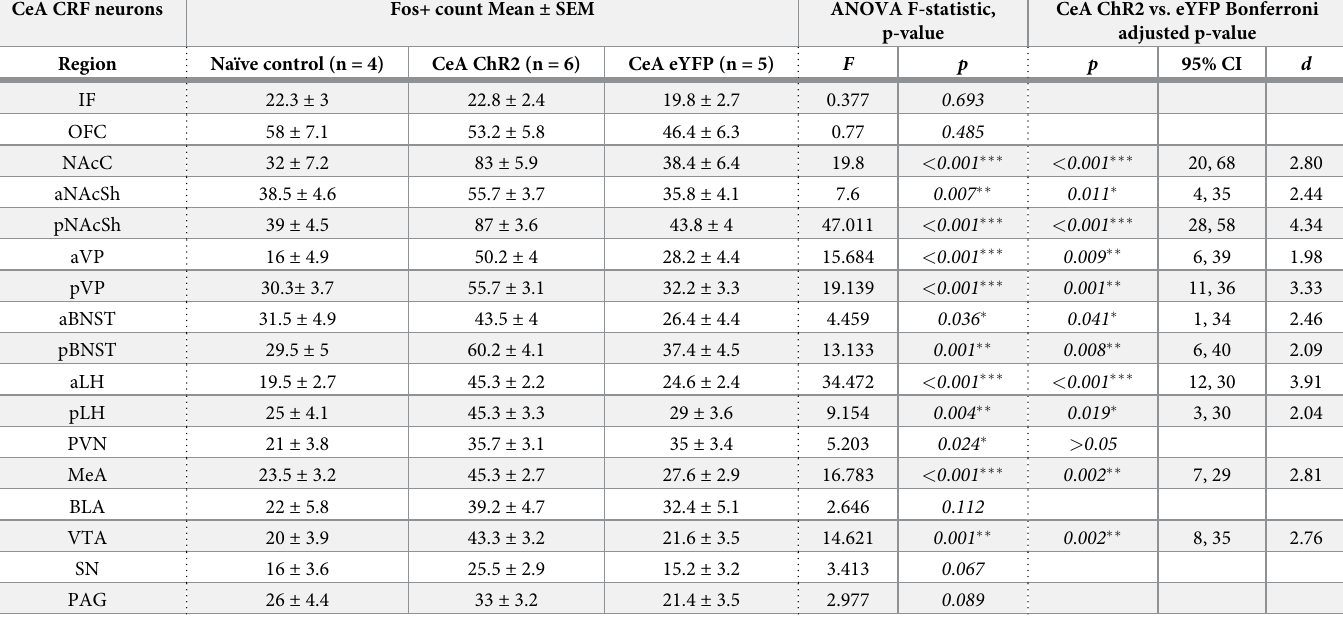
Table shows Fos+ protein quantification in mesocorticolimbic regions after final exposure to ChR2 excitation in CeA (n = 3 female, n = 3 male). Fos+ protein quantification in mesocorticolimbic regions (left columns) for na ï ve unoperated control rats, ChR2 rats, and eYFP rats, were compared with a one-way ANOVA for each structure targeted. “Fos+ Count” reflects the mean of each group at each site ± standard error (SEM). Follow up two-tailed t-tests with Bonferonni corrections were performed between ChR2, eYFP, and naiive control groups. The right column includes p- values, confidence intervals, and effect sizes for instances where ChR2 rats were found to significantly differ from eYFP controls. Percent change in ChR2 rats from eYFP controls are depicted in Fig 3. IF, infralimbic cortex; OFC, orbitofrontal cortex; aNAcSh, anterior nucleus accumbens shell; pNAcSh, posterior nucleus accumbens shell; NAcC, nucleus accumbens core; aVP, anterior ventral pallidum; pVP, posterior ventral pallidum; aBNST, anterior bed nucleus of stria terminalis; pBNST, posterior bed nucleus of stria terminalis; aLH, anterior lateral hypothalamus; pLH, posterior lateral hypothalamus; PVN, hypothalamic paraventricular nucleus; MeA, medial amygdala; CeA, central amygdala; BLA, basolateral amygdala; VTA, ventral tegmentum; SN, substantia nigra; PAG, midbrain periaqueductal gray. � p < 0.05, �� p < 0.01, ��� p <